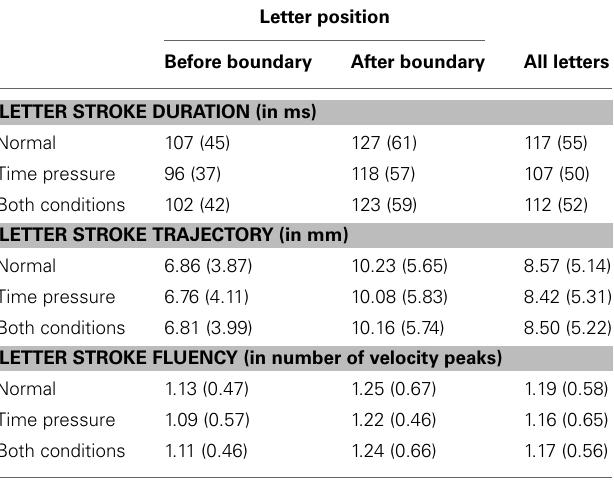
Table 2 sets out the letter stroke fluency means as a function of position and writing condition. Writing condition did not